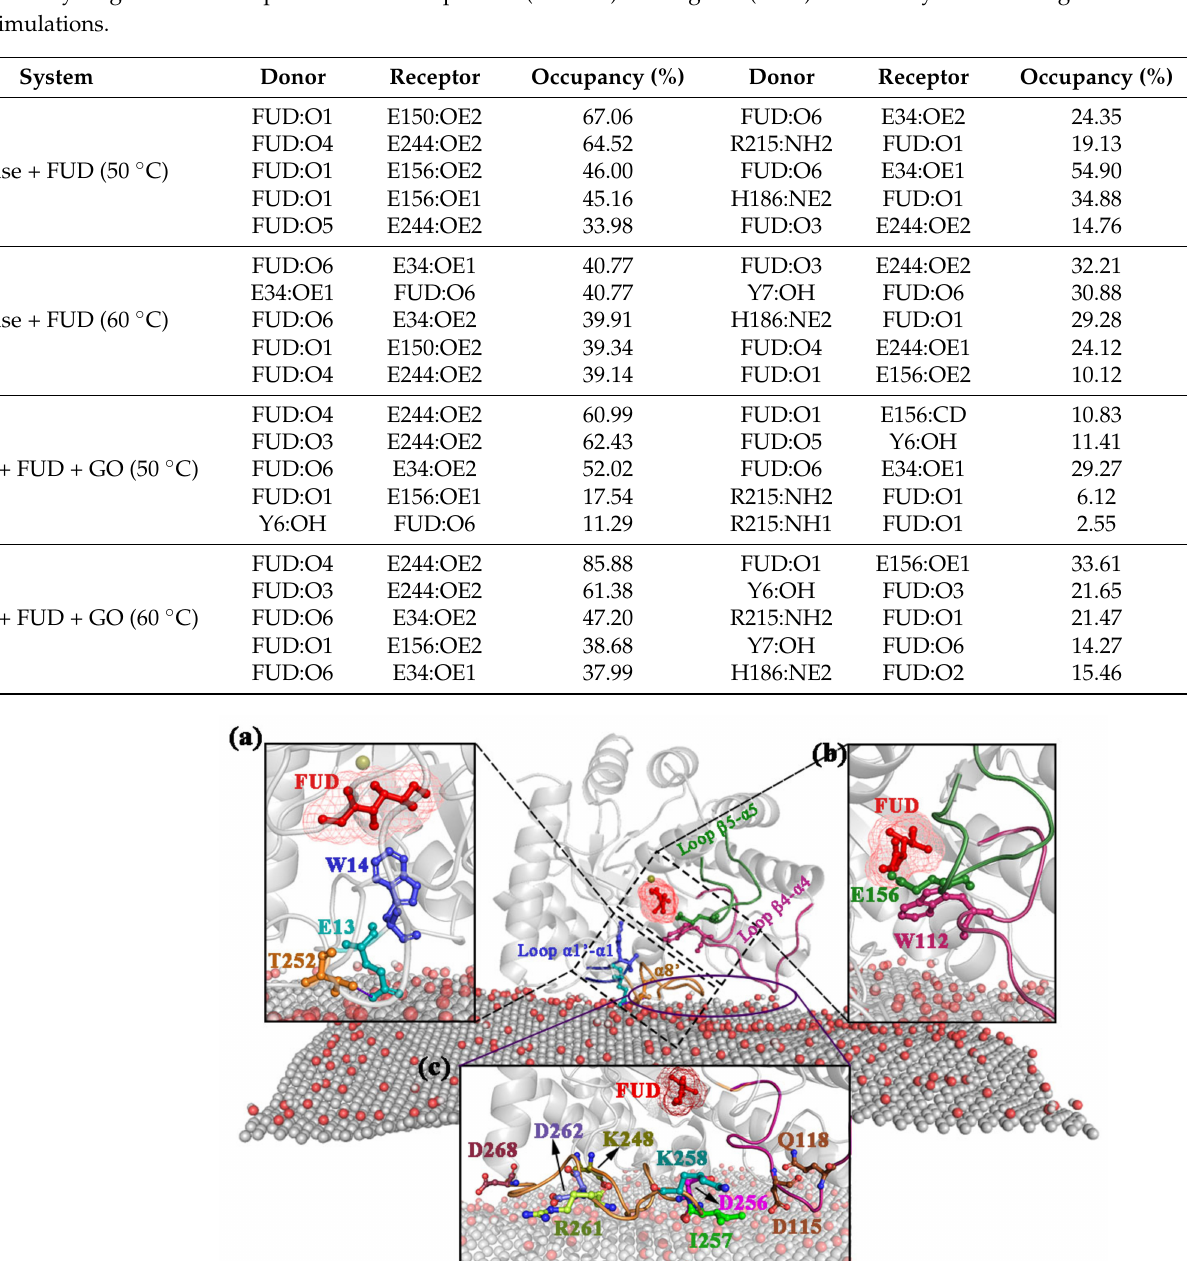
Figure 5. The detailed close-up of the interaction surface between DPEase and GO. ( a ) The interaction between loop α 1 (cid:48) - α 1 and α 8 (cid:48) ; ( b ) the interaction between loop β 4- α 4 and loop β 5- α 5 (cid:48) ; ( c ) structure diagram of the adsorbed region. The key residues have been marked in the picture with different color